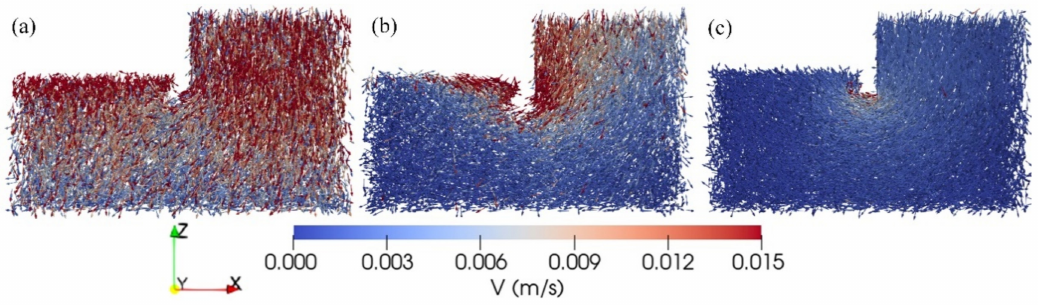
Figure 2. Spatial distribution of particle velocity for specimen ( a ) FC30; ( b ) FC40; and ( c ) FC60.